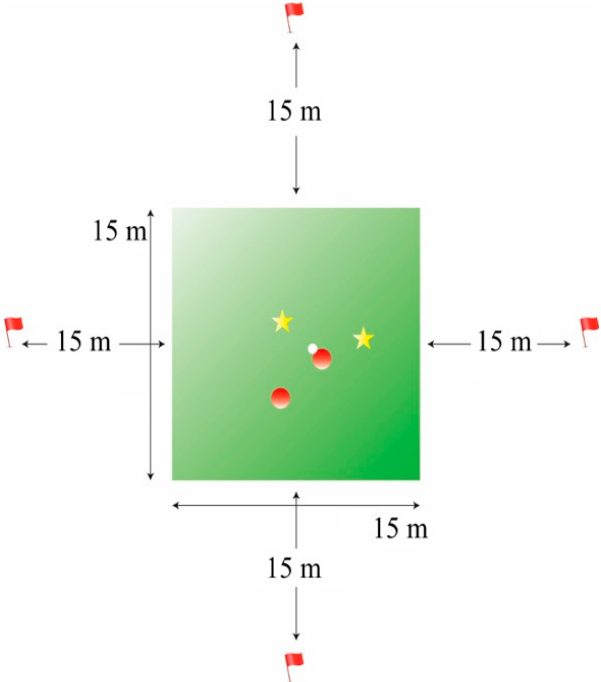
Figure 1. Soccer-specific fatigue protocol (SSFP) diagram.